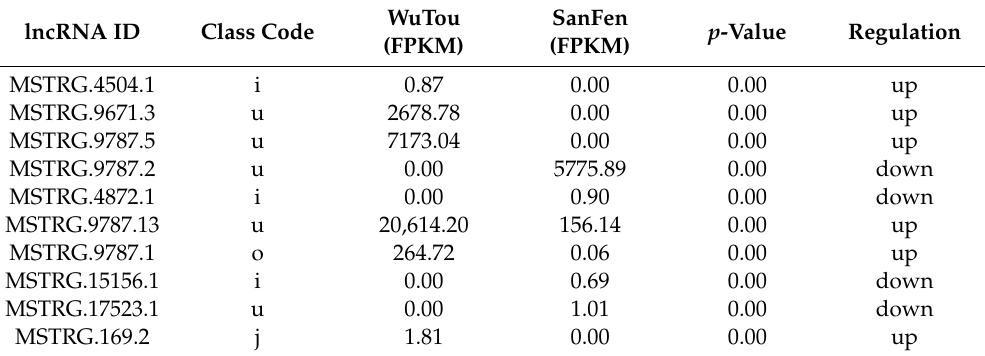
Table 2. The top 10 most significantly expressed lncRNAs of longissimus dorsi muscle. lncRNA ID Class Code